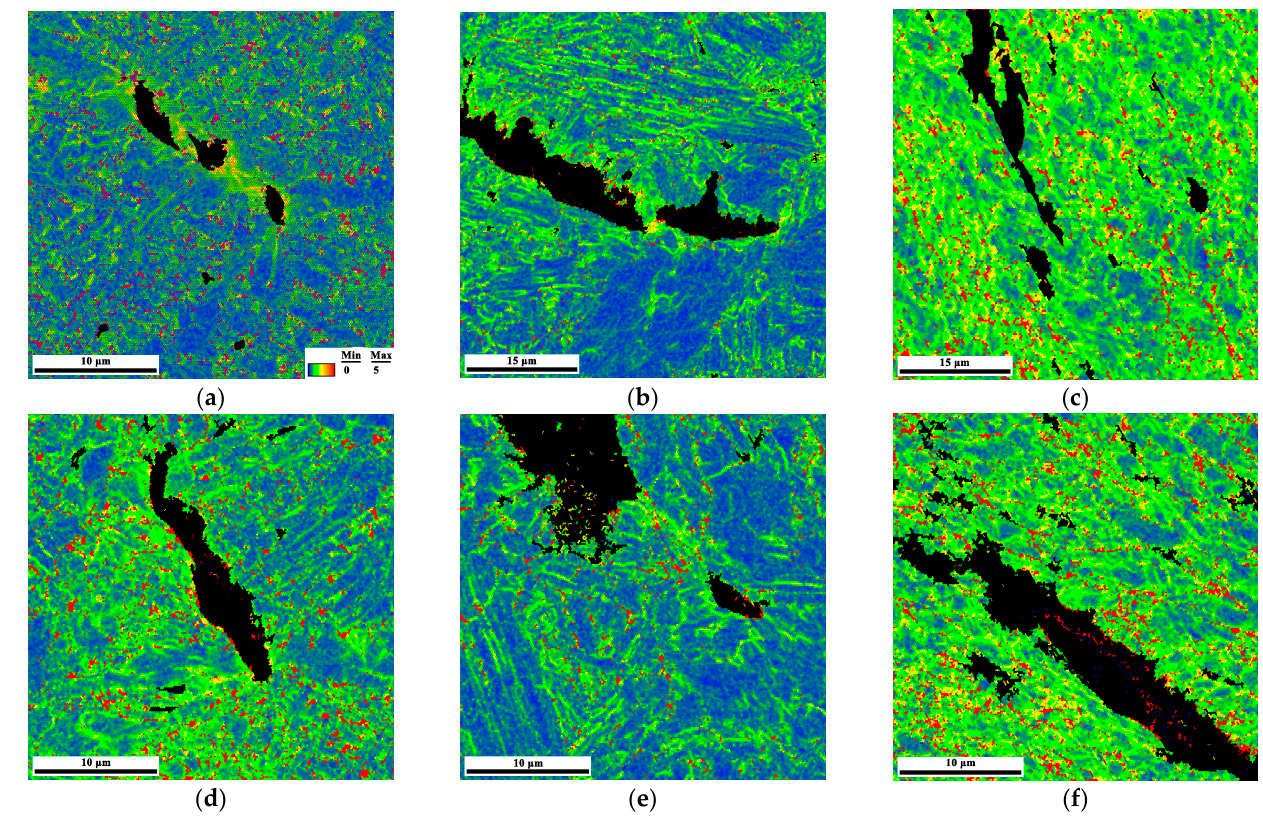
Figure 10. KAM maps of secondary cracks in the H 2 S ‐ containing environment: ( a ) WM, ( b ) CGHAZ, ( c ) SCHAZ; KAM maps of secondary cracks in air environment: ( d ) WM, ( e ) CGHAZ, ( f ) SCHAZ.